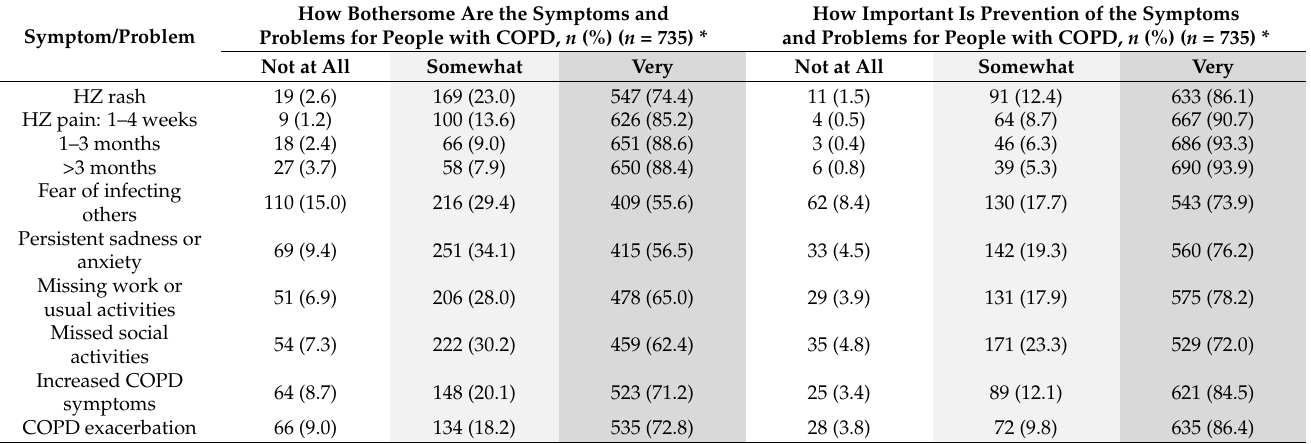
Table 2. Participants’ perceived impact of symptoms and problems of HZ, and the importance of preventing them, for people with COPD.